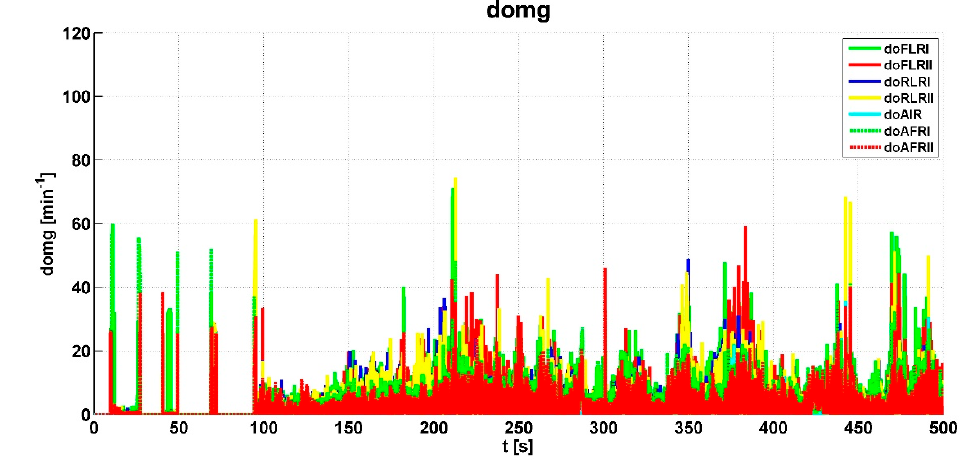
Figure 9. Values of shaft speed differences.